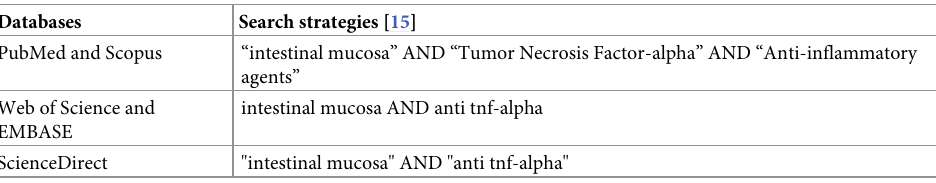
Table 1. Search strategies used in each database to select articles to compose the systematic review, aiming to answer the question: What are the mechanisms of action of molecules with anti-TNF- α activity in the intestinal